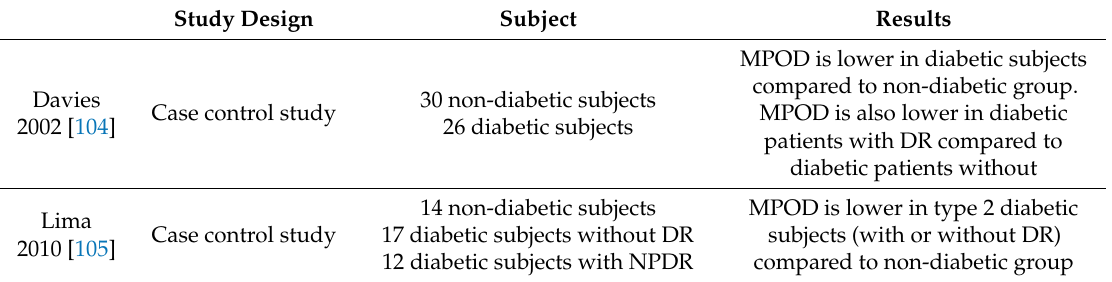
Table 7. Studies showing the association between MPOD and diabetic retinopathy (DR) risks.